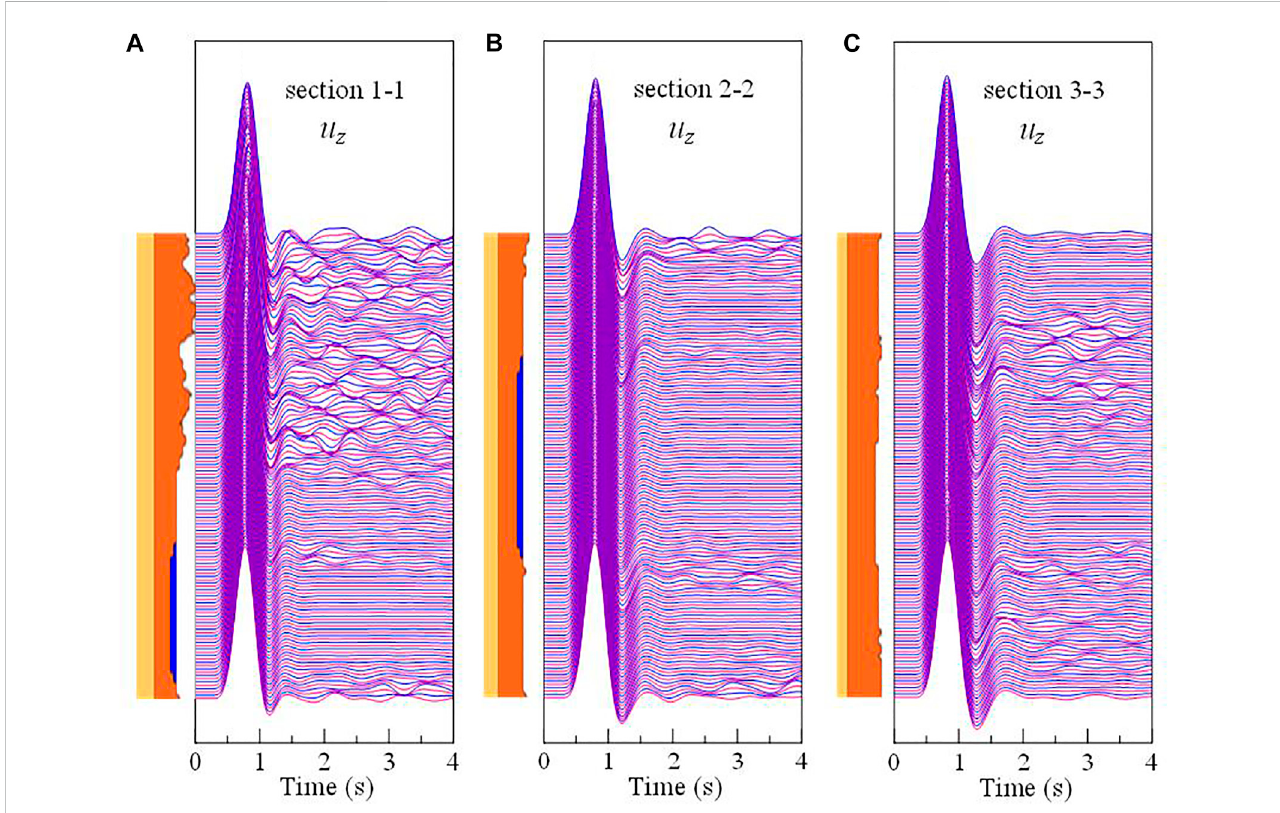
FIGURE 10 (A) Displacement waveforms in z-direction of section 1-1; (B) Displacement waveforms in z-direction of section 2-2; (C) Displacement waveforms in z- direction of section